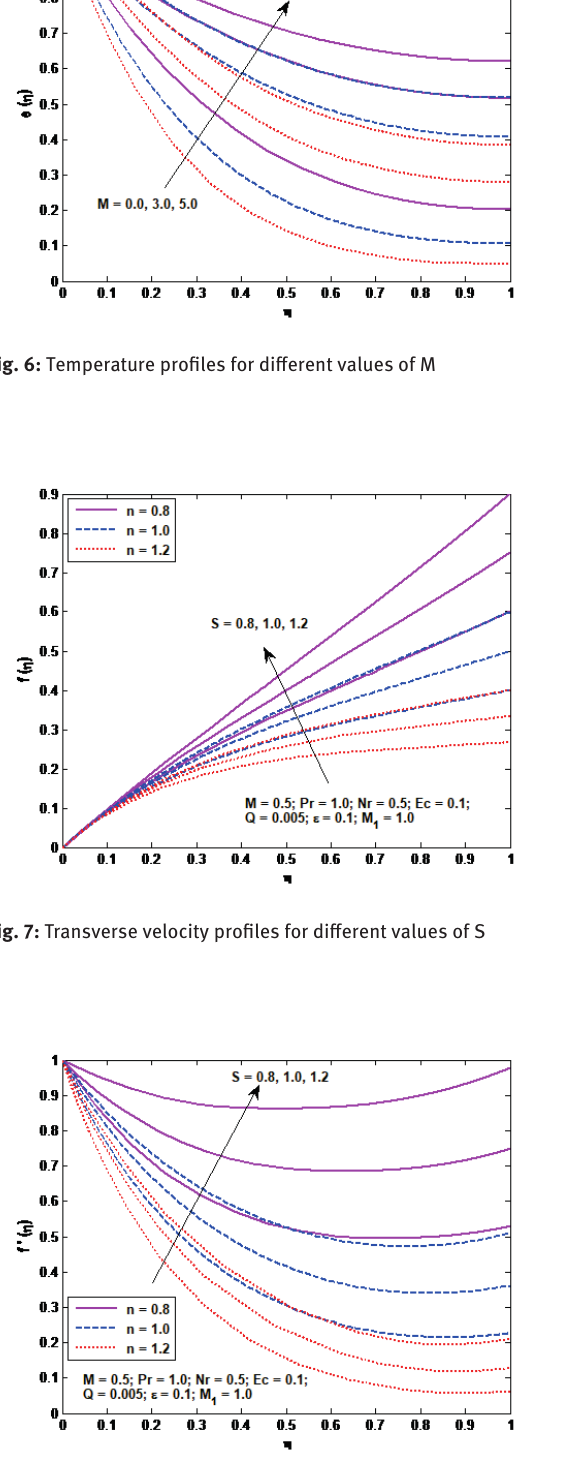
Fig. 11: Temperature profiles for different values of